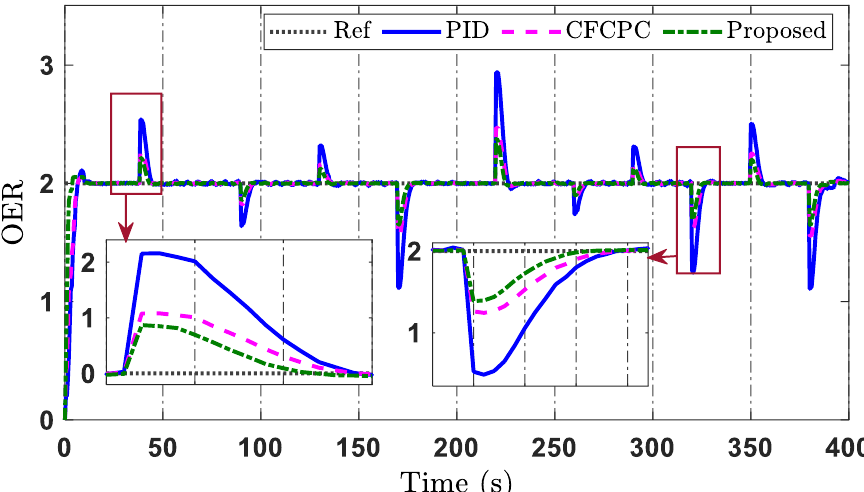
Figure 10. Performance comparison of the proposed and comparative controllers in the experiment.